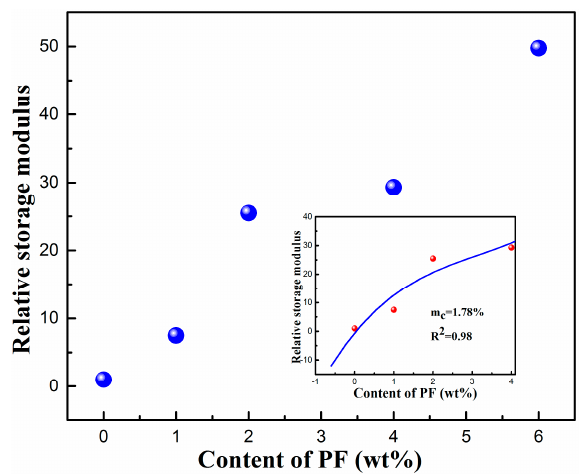
Figure 7. The dependence of relative storage modulus on the content of PF for TPVs.